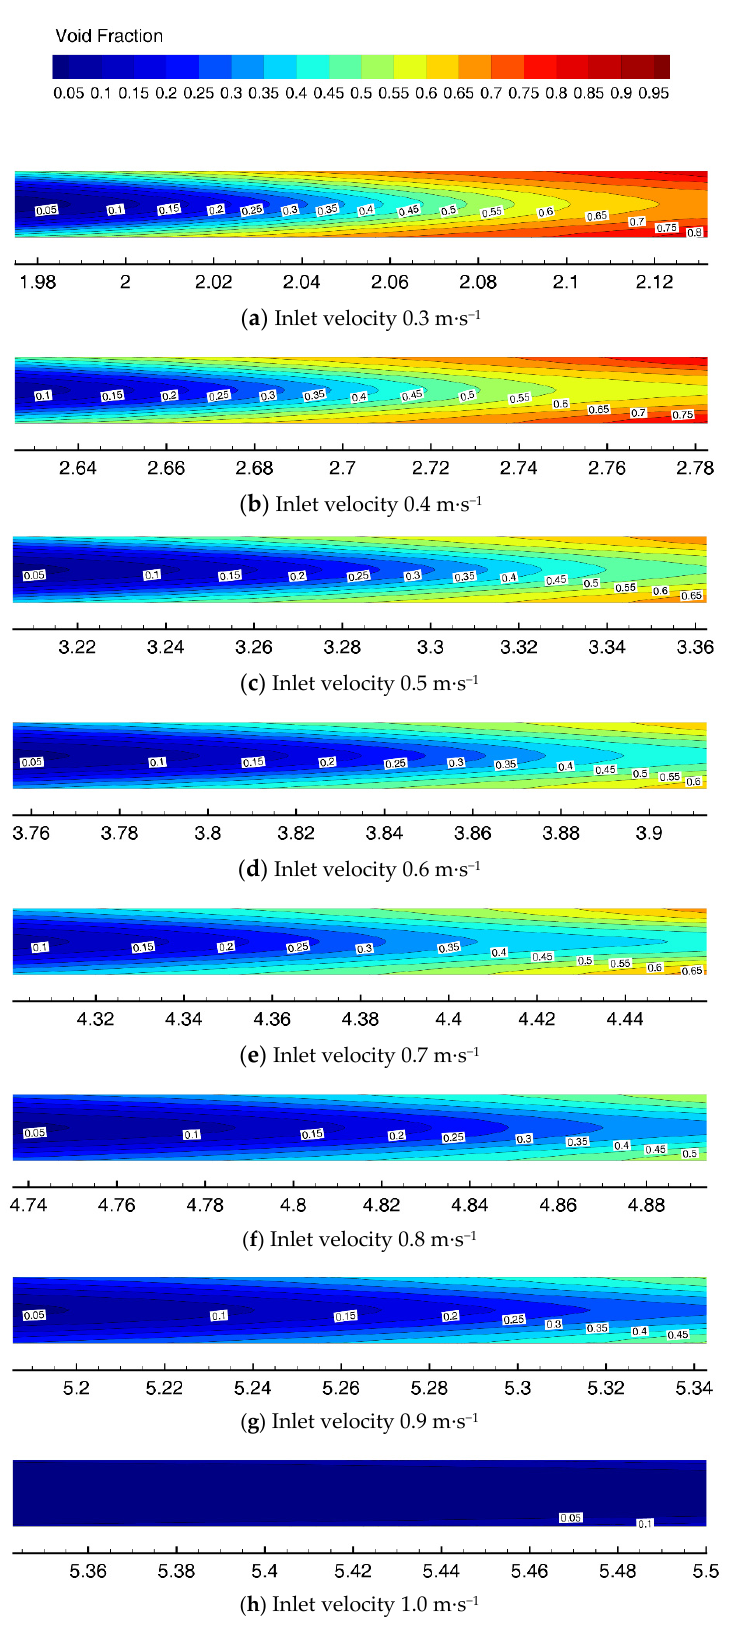
Figure 11. Local void fraction distributions at inlet velocities ranging from 0.3 m·s − 1 to 1.0 m·s − 1 ( x -axis is the axial distance).